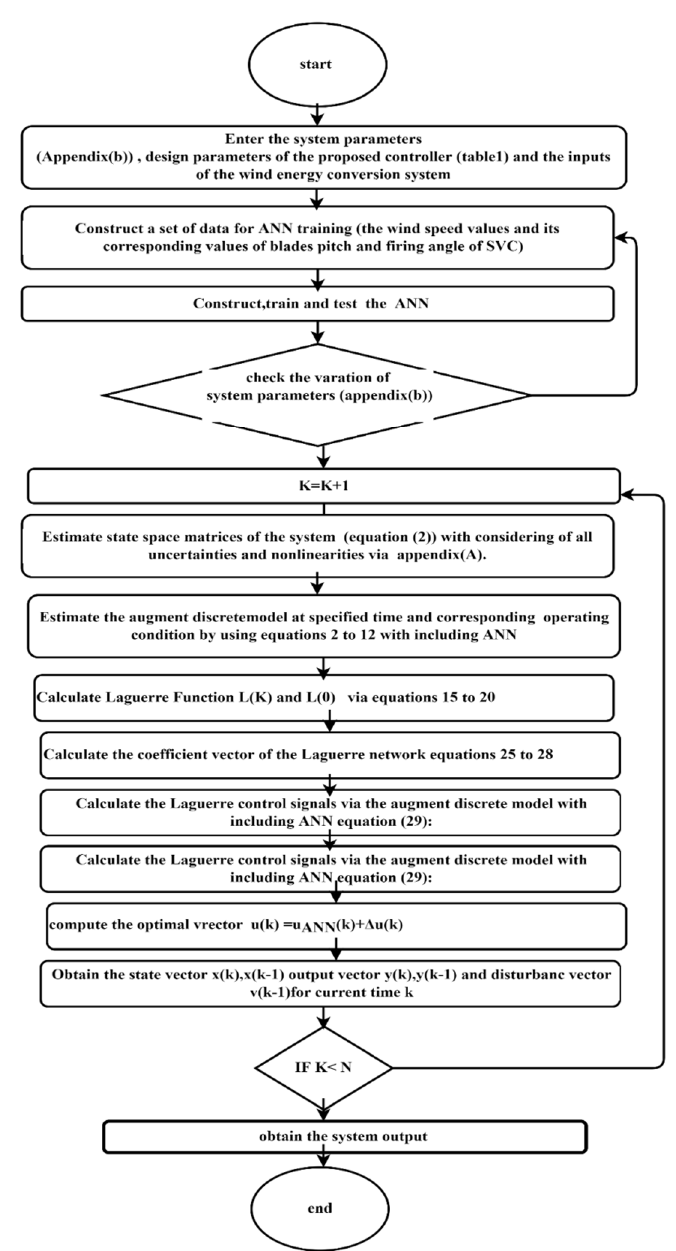
Figure 5. Discrete-time Laguerre network.